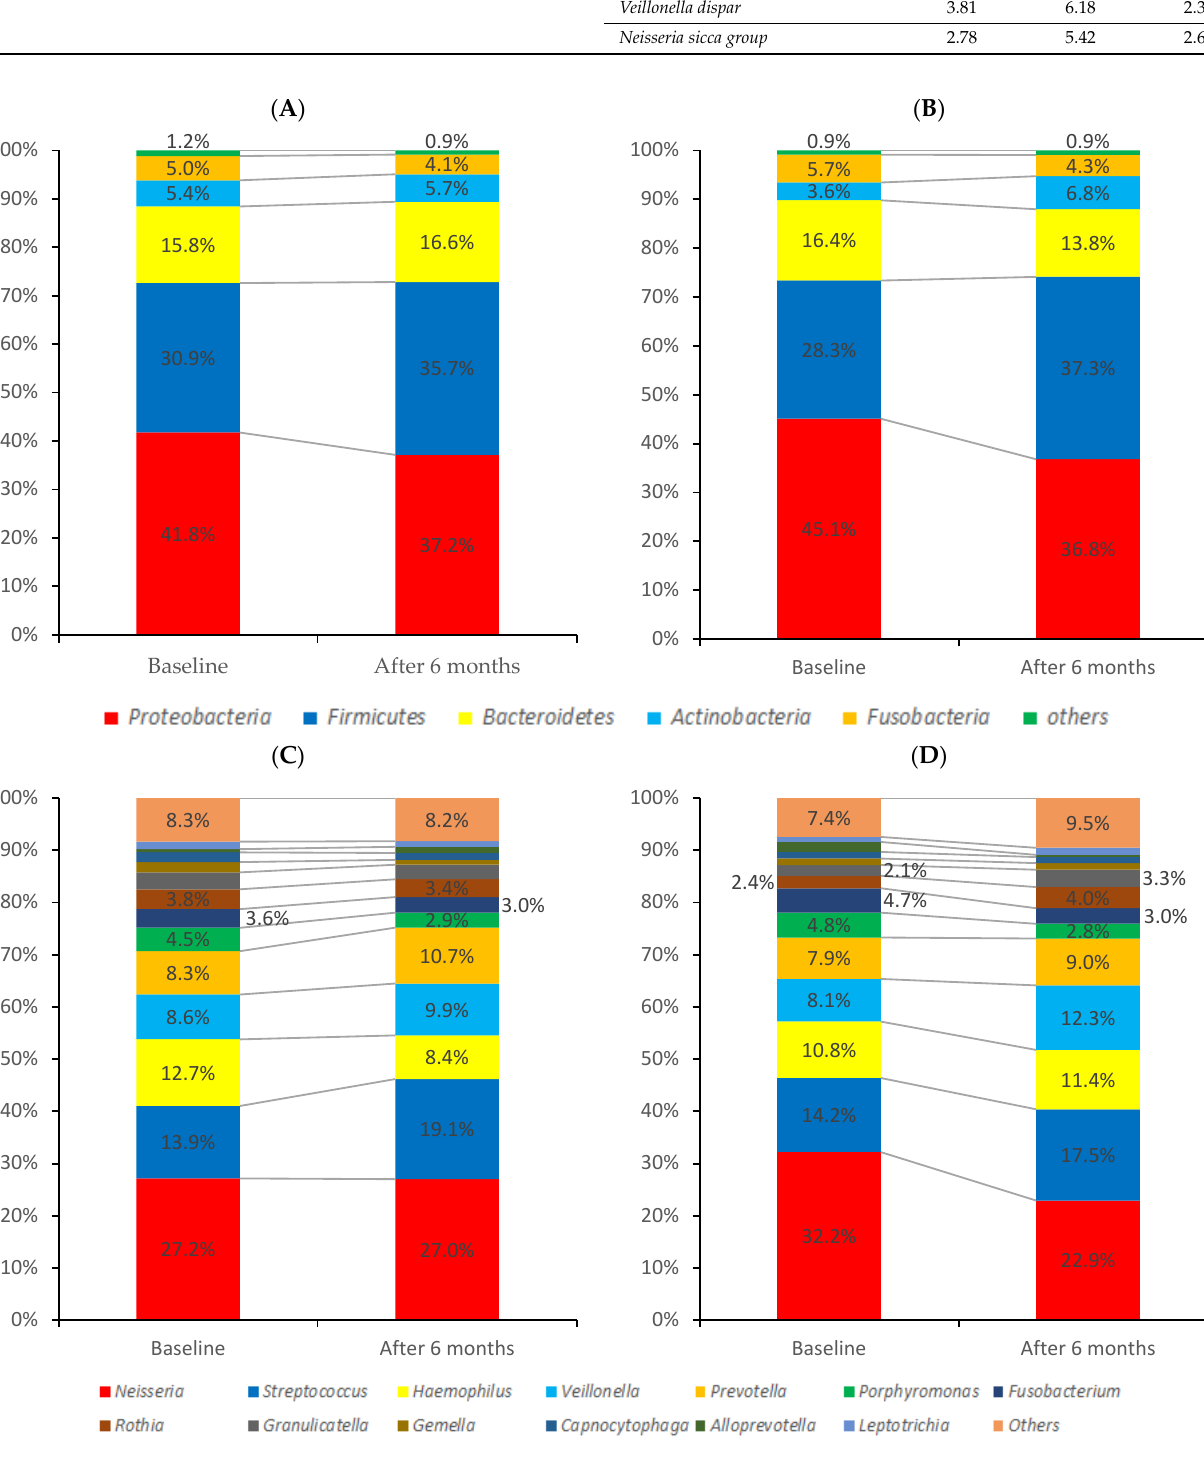
Figure 3. Oral microbiome structure before and after treatment. Data are presented separately phylum, and genus level. ( A ) Tooth surface disinfection group at phylum level. ( B ) Fluoride application group at phylum level. ( C ) Tooth surface disinfection group at genius level. ( D ) Fluoride application group at genus level.